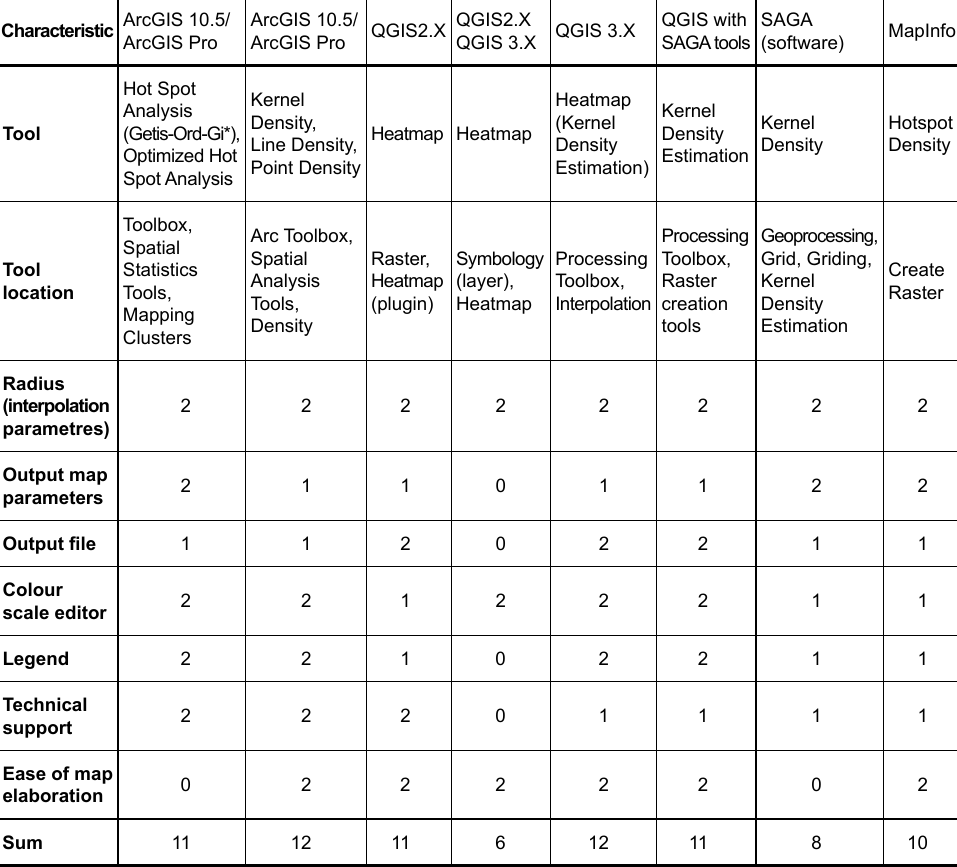
Tab. 2. Tool evaluation questionnaire in popular GIS programs ArcGIS 10.5/ Characteristic ArcGIS